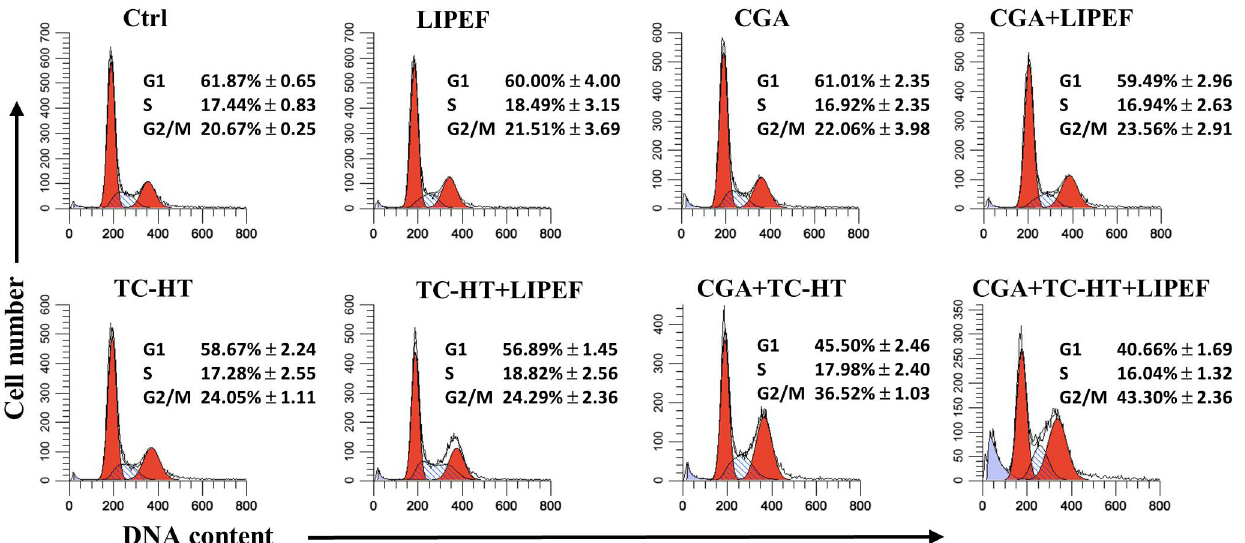
Fig 4. Effects of CGA, TC-HT, and LIPEF on PANC-1 cell cycle distribution. Cells were treated with CGA (200 μ M), TC-HT (10-cycles), and LIPEF (60 V/cm) alone, in double or triple combination for 24 h, stained with PI and analyzed by flow cytometry for cell cycle analysis. Each histogram indicating the DNA content (x-axis) vs. cell number (y-axis) is representative of three independent experiments. The percentages of cells presented as mean ± S.D in G1, S, and G2/M phases are listed.